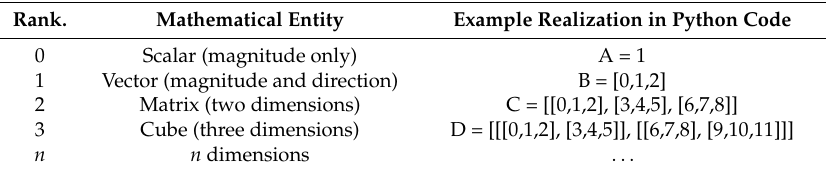
Table 1. Tensor rank (0 to n ) with an example code using Python